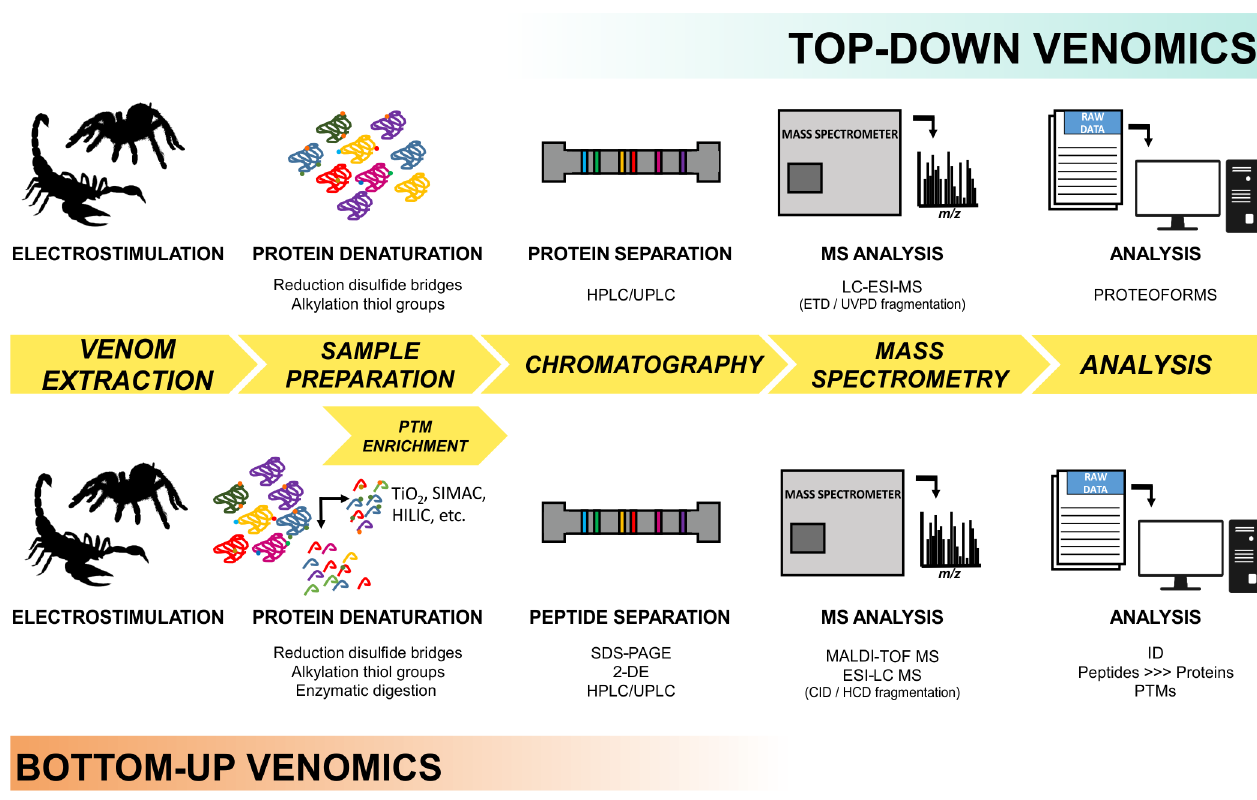
Figure 2. Venomic workflow. General workflows for top-down and bottom-up venomics are